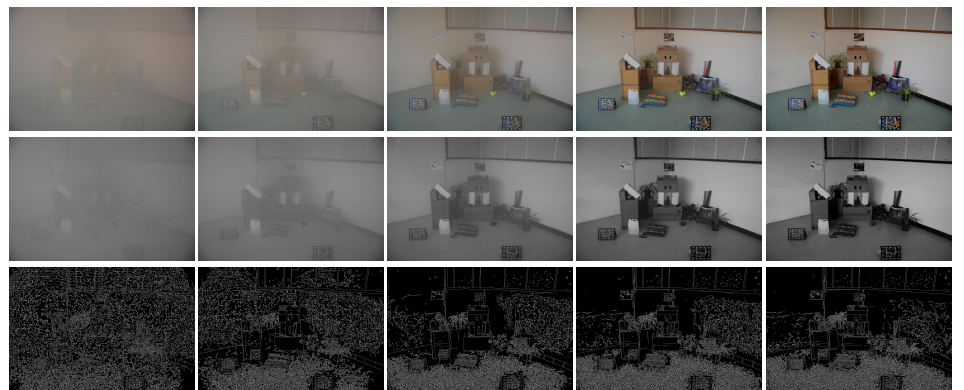
Figure 1. Fog density and pseudo-edge details. The first row shows five images with different fog den- sity values (from left to right, the fog density changes from high to low) [16]. The corresponding dark channel images and pseudo-edge details are presented on the second and third rows,